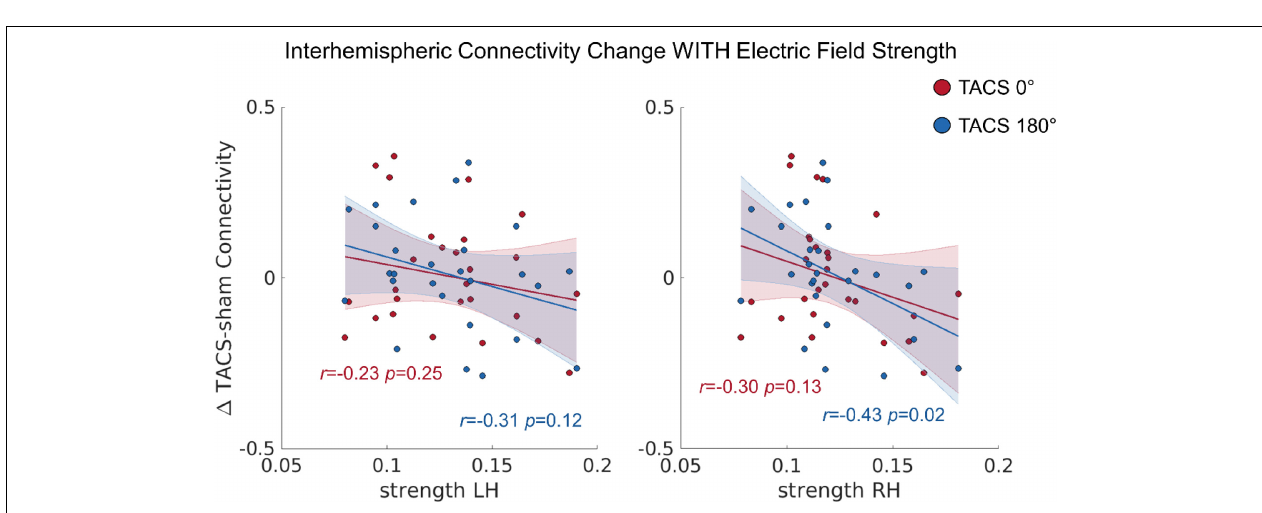
FIGURE 4 | The correlation between the tACS induced BOLD signal change and the individual electric field strength in LH and RH. r = Pearson correlation. Error ribbon represents the 95% confidence interval obtained for the fit of a robust linear regression.